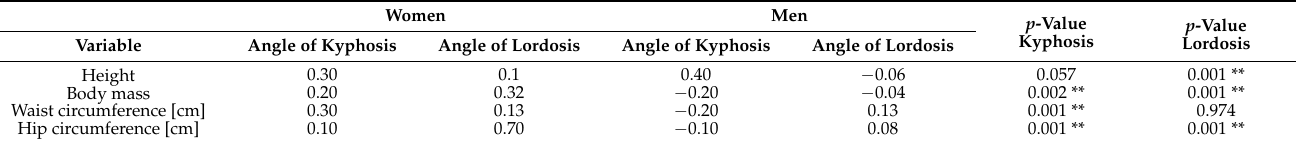
p -Value Kyphosis 0.001 ** 0.001 **